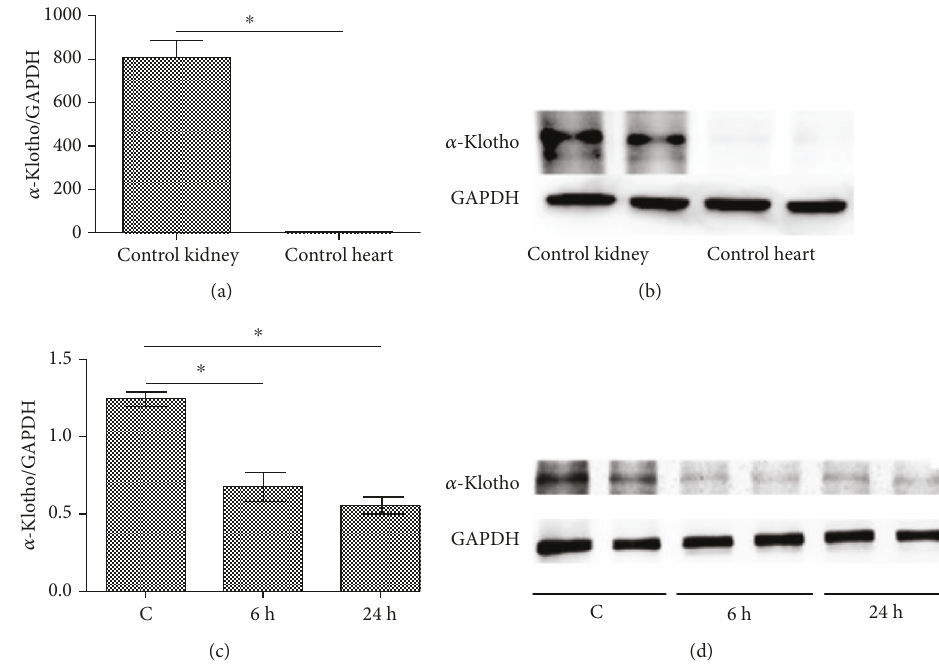
Figure 2: LPS decreased renal α -klotho expression (a – d). Mouse heart and kidney tissues were collected from the control group ( n = 6 ). Real- time PCR and western blotting analysis showing the expression of α -klotho mRNA (a) and protein (b) levels in the control ’ s hearts and kidneys. Mouse kidney samples were collected at 0 h, 6 h, and 24 h after LPS (10 mg/kg) injection in the LPS group ( n = 6 ). Real-time PCR and western blotting analysis showing the expression of α -klotho mRNA (c) and protein (d) levels in mouse kidneys. ∗ p < 0 05